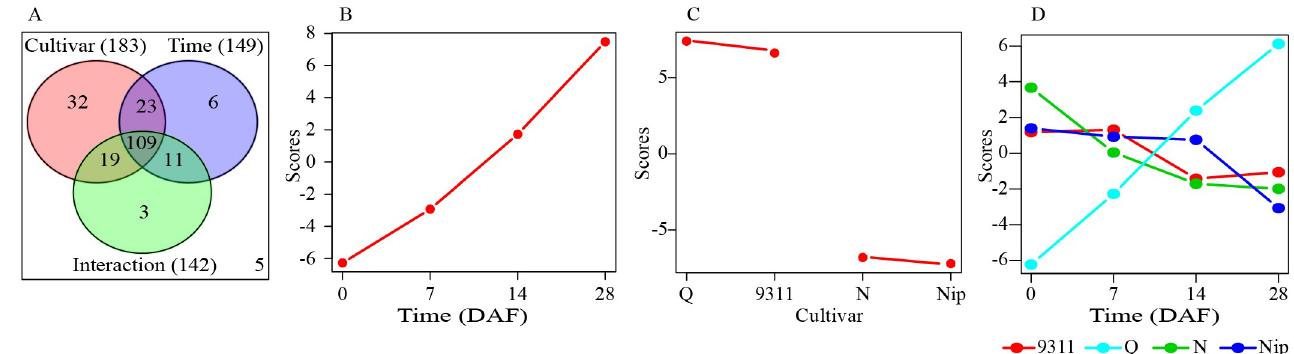
Fig 2. Result of two-way ANOVA and ASCA. (A) Venn diagram summary of results from two-way ANOVA. (B) Major pattern associated with cultivar. (C) Major pattern associated with time. (D) Major pattern associated with the interaction between cultivar and time. These analyses were performed in MetaboAnalyst website